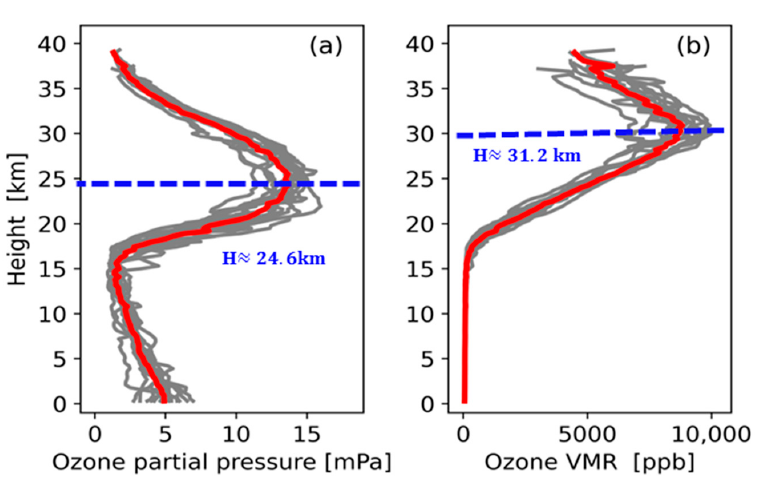
Figure 3. Vertical profiles of ( a ) ozone partial pressure and ( b ) OVMR for the average of all observations (red line) , individual profiles (grey line) and the height corresponding to the average value (blue dotted line) during spring 2022 at Shaowu station.